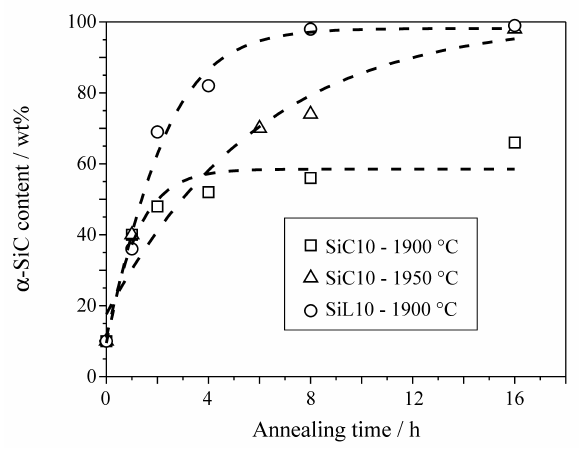
Figure 10. Results of β -SiC to α -SiC phase transformation kinetics investigation.